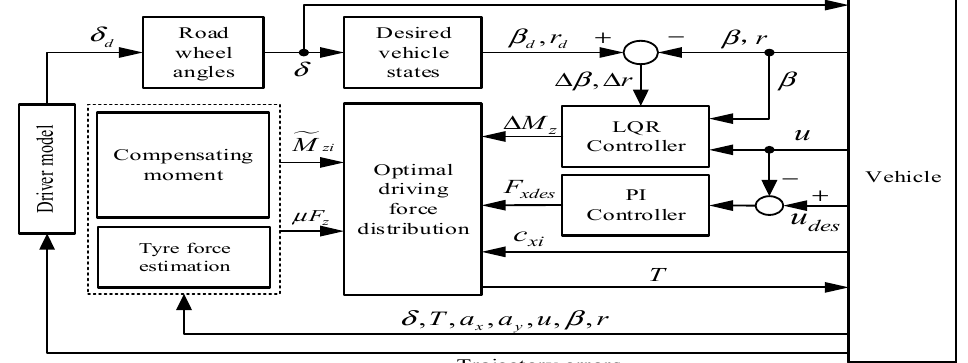
Figure 3. Control strategy of the fail-operation steering system.